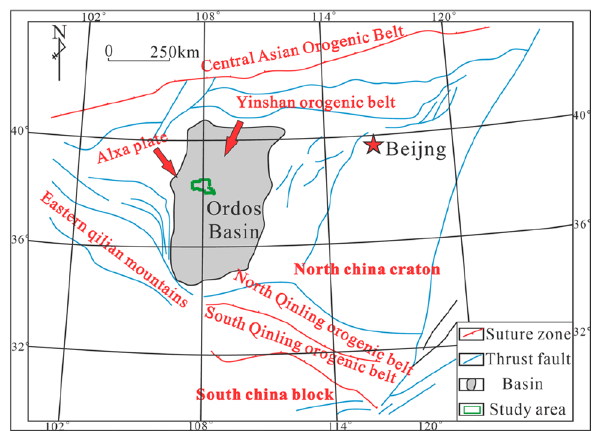
Figure 1. Distribution of the bidirectional provenance system in the Jiyuan area of the Ordos Basin, modified from reference 13 . Created using CorelDRAW-X9 21.2.0.706 (http:// www. corel draw. com/